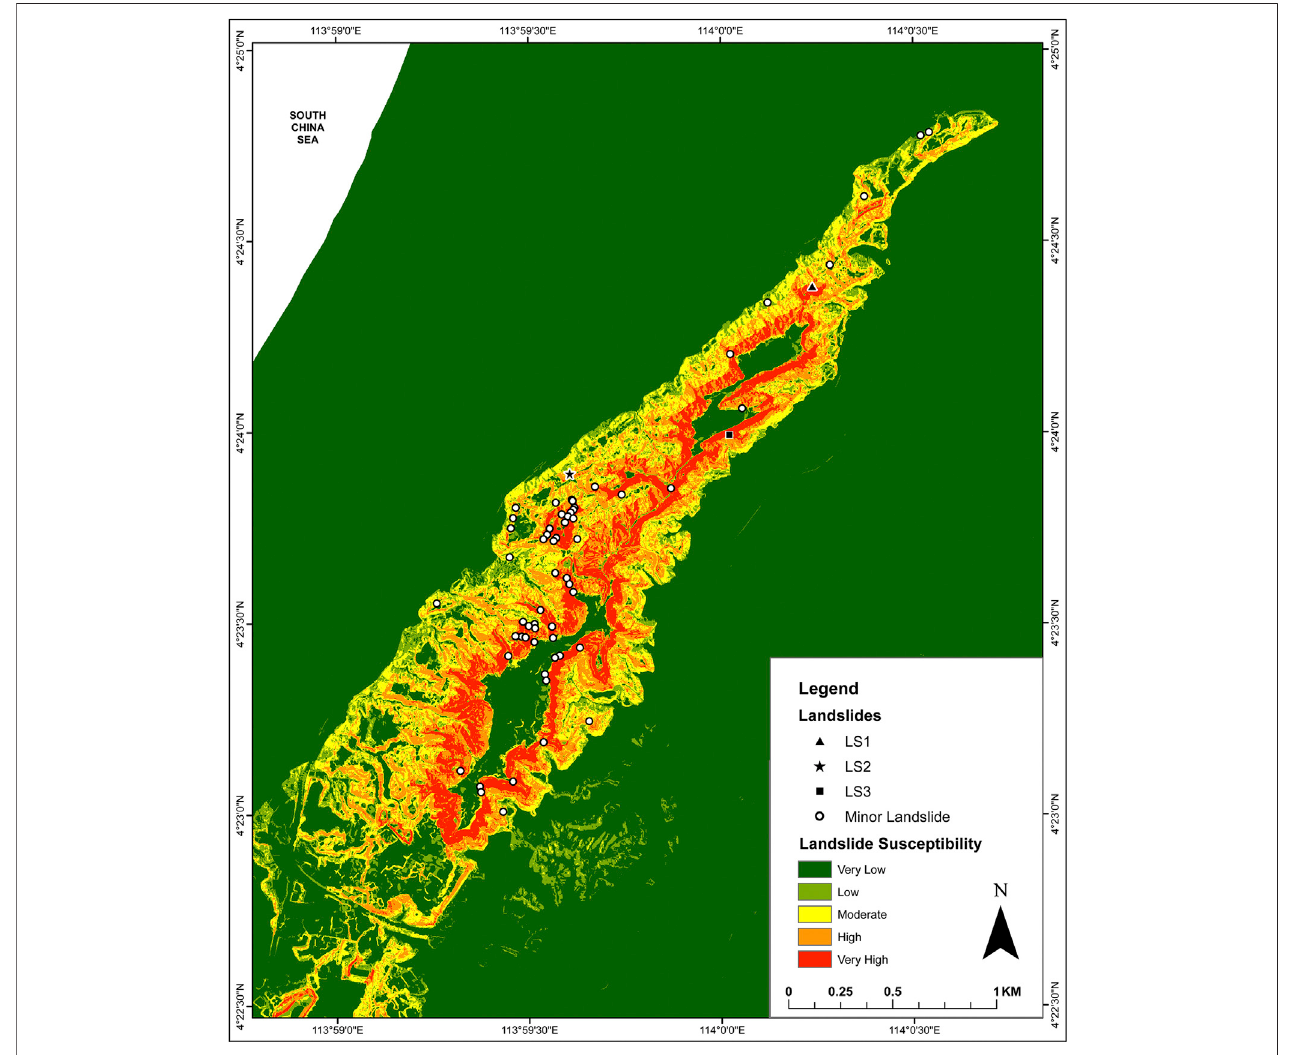
FIGURE 4 | Landslide susceptibility map of Canada Hill produced from six parameters; geology and geomorphology, distance to lineament, slope gradient, elevation, slope curvature, and slope aspect.